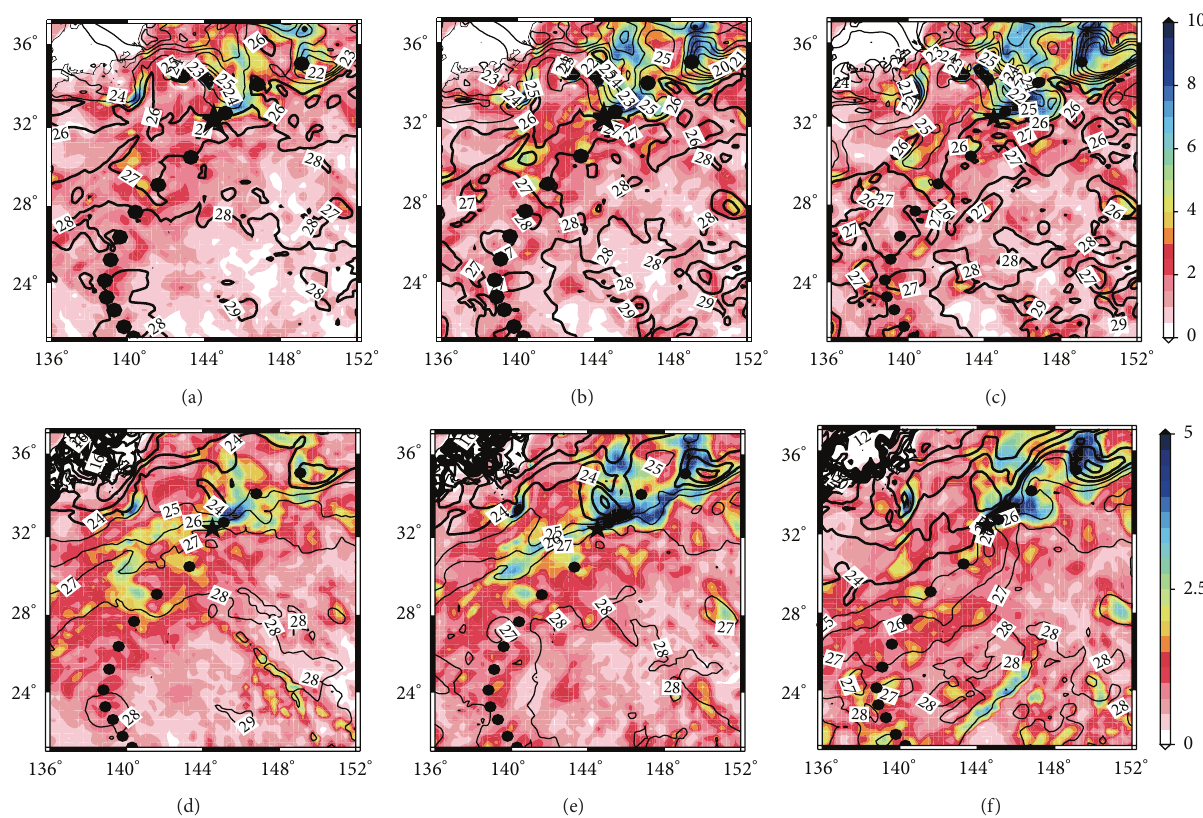
Figure 11: Same as Figure 10 except for (a–c) sea surface temperature and (d–f) air temperature at 20m height at (a, d) 24 h, (b, e) 48h, and (c, f)